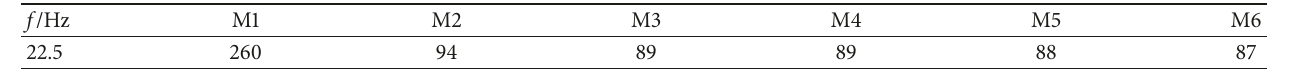
Table 4: Phase difference of monitor M series.